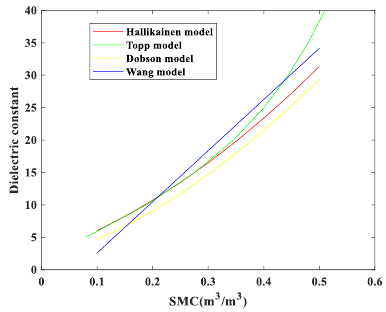
Figure 16 . The four soil models on Chinese silty clay loam （ C=0.3 ， S=0.25 ） .